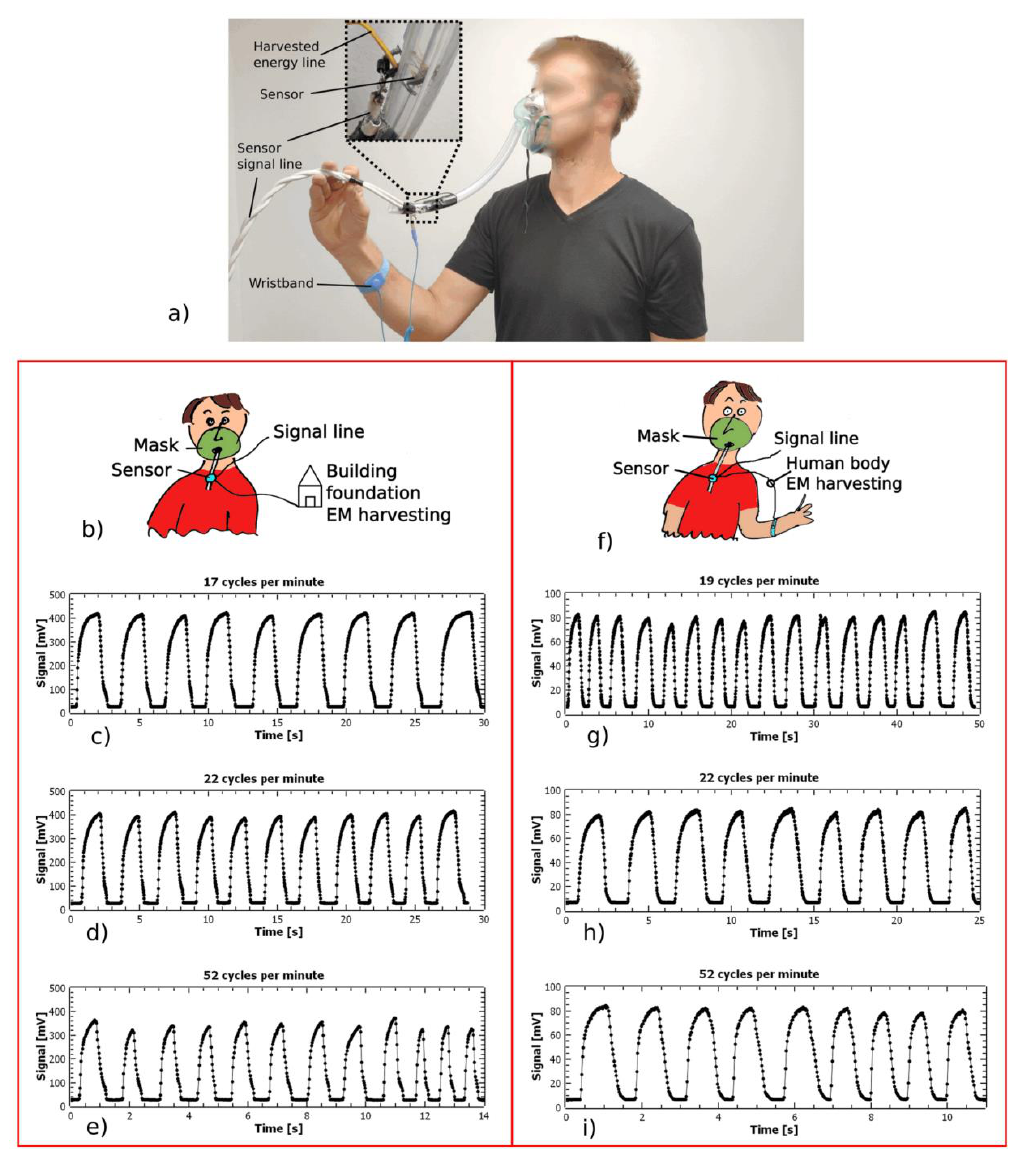
Figure 4. The sensor test on breathing with a mask: ( a ) The mask used for the breathing test with the sensor connected to the EM harvesting using a wristband. The sensor fixture (inset); ( b ) Schematic of the sensor test with mask breathing using building foundation as an EM source. The maximum signal was up to 400 mV; ( c ) Breath speed 17 cpm; ( d ) 22 cpm; ( e ) 52 cpm; ( f ) Schematic of the sensor test with mask breathing using human body as an EM source. The maximum signal was up to 80 mV; ( g ) Breath speed 19 cpm; ( h ) 22 cpm; ( i ) 52 cpm.